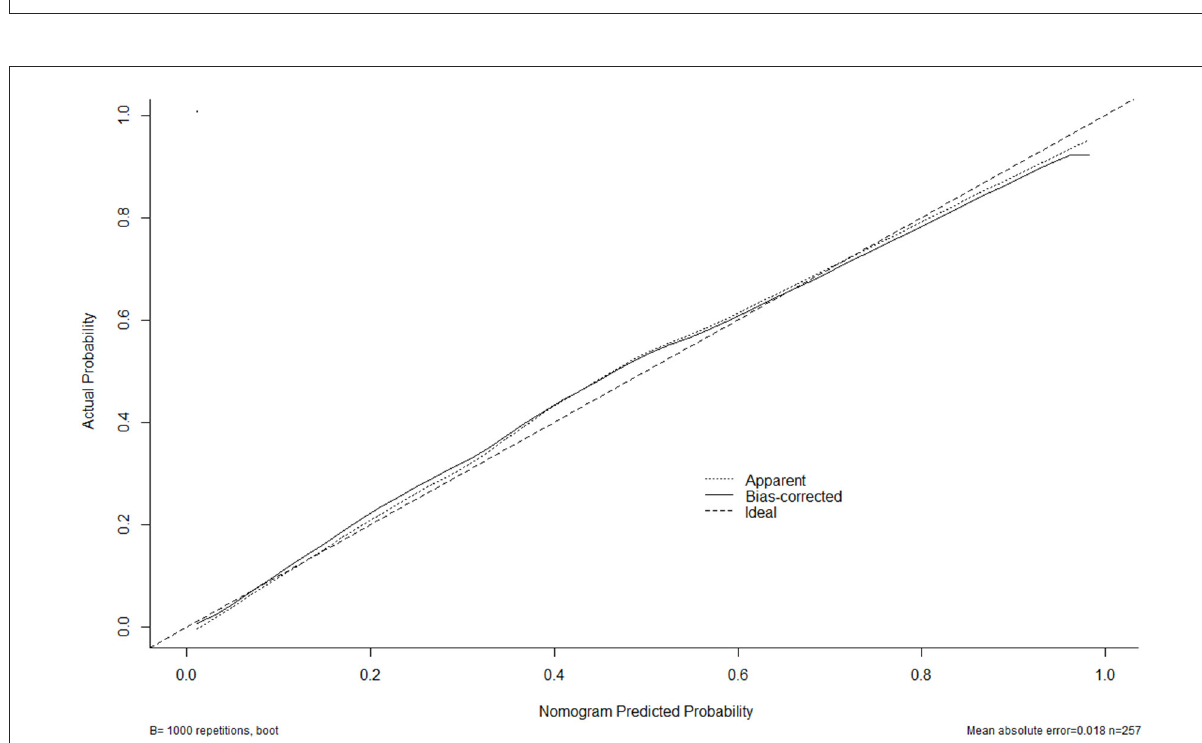
FIGURE9 Calibration curves of the nomogram for predicting poor outcome after aneurysmal subarachnoid hemorrhage. The x -axis denotes the predicted poor outcome. The y -axis denotes the actual poor outcome. The diagonal dotted line means a perfect prediction using an ideal model. The solid line represents the performance of the nomogram, of which the closer fit to the diagonal dotted line indicates the better prediction of the